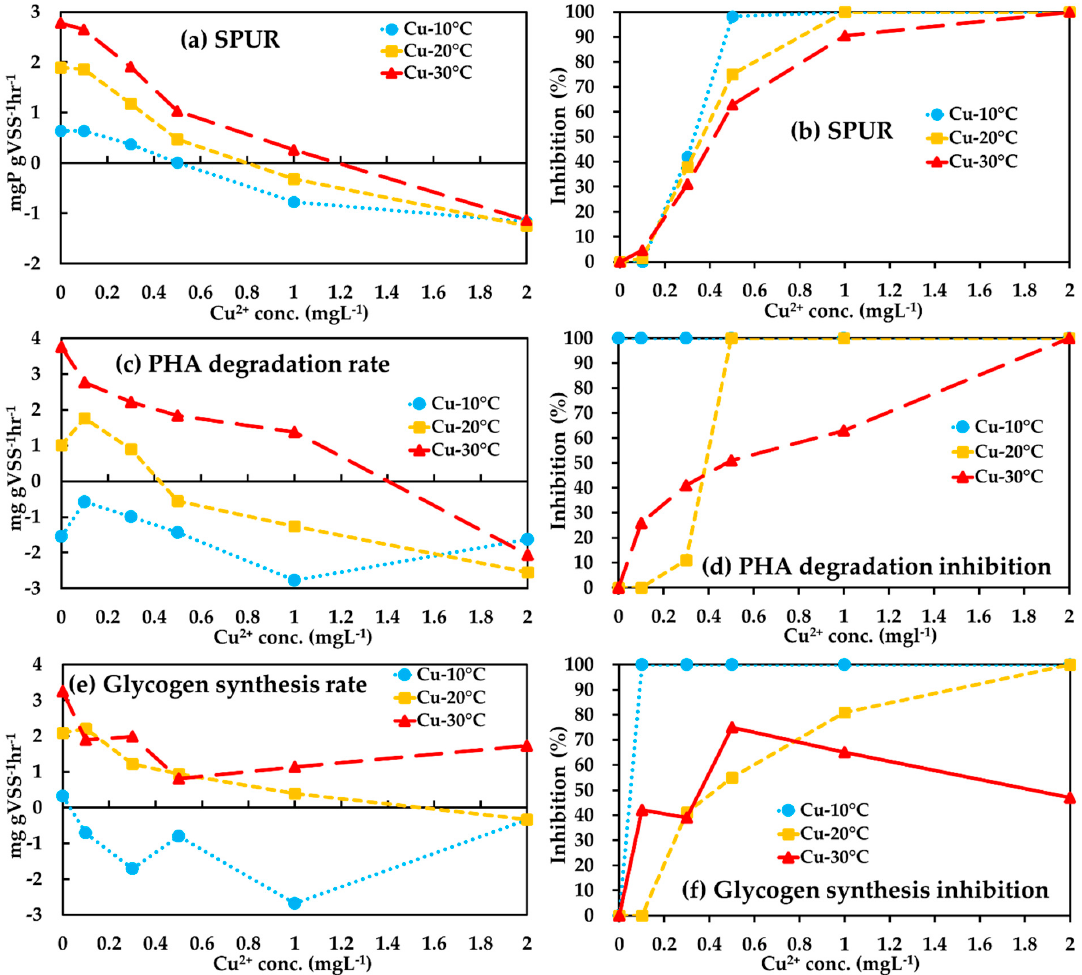
Figure 3. Copper toxic effects on aerobic specific phosphorus uptake rate (SPUR), PHAs degradation, and glycogen synthesis under different temperature conditions. ( a ) SPUR; ( b ) SPUR inhibition; ( c ) PHA degradation rate; ( d ) PHA degradation inhibition; ( e ) Glycogen synthesis rate; ( f ) Glycogen synthesis inhibition.